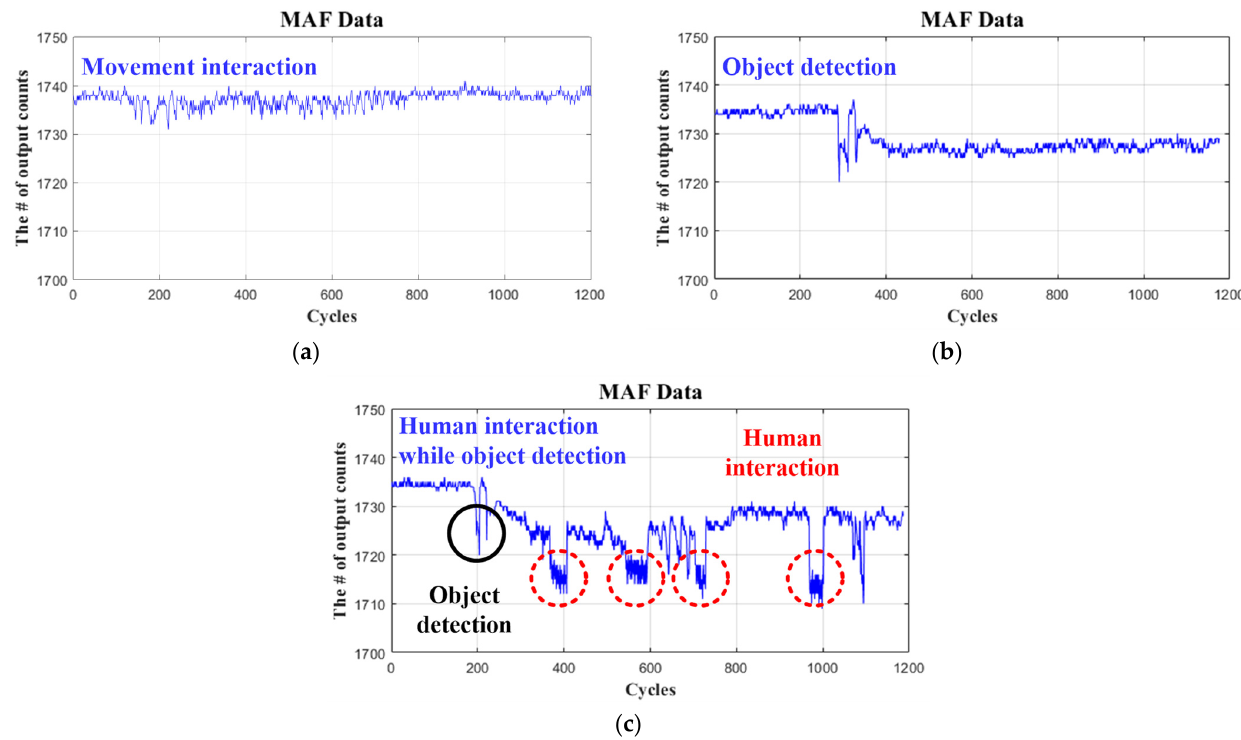
Figure 9. The MAF data of ( a ) movement interaction; ( b ) object detection; ( c ) human interaction while an object is on the electrode.